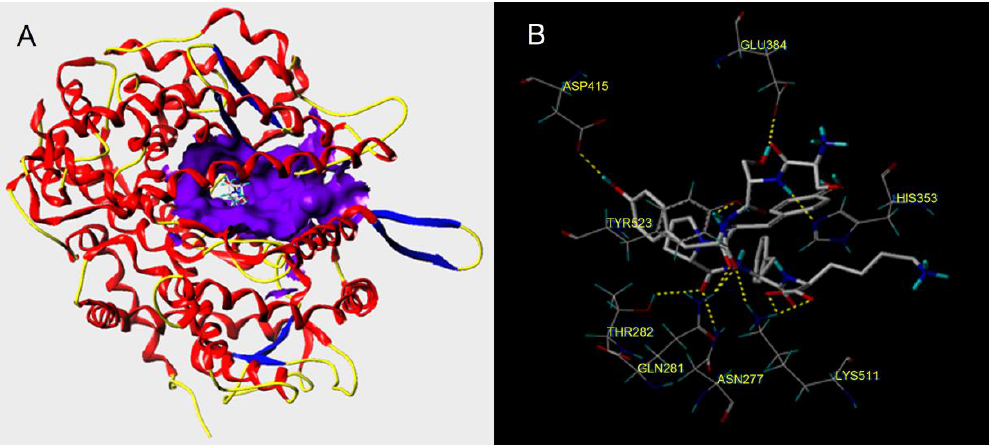
Figure 6. General overview ( A ) and local overview ( B ) of the best-ranked docking pose of RWDISQPY binding with ACE (PDB: 1O8A).